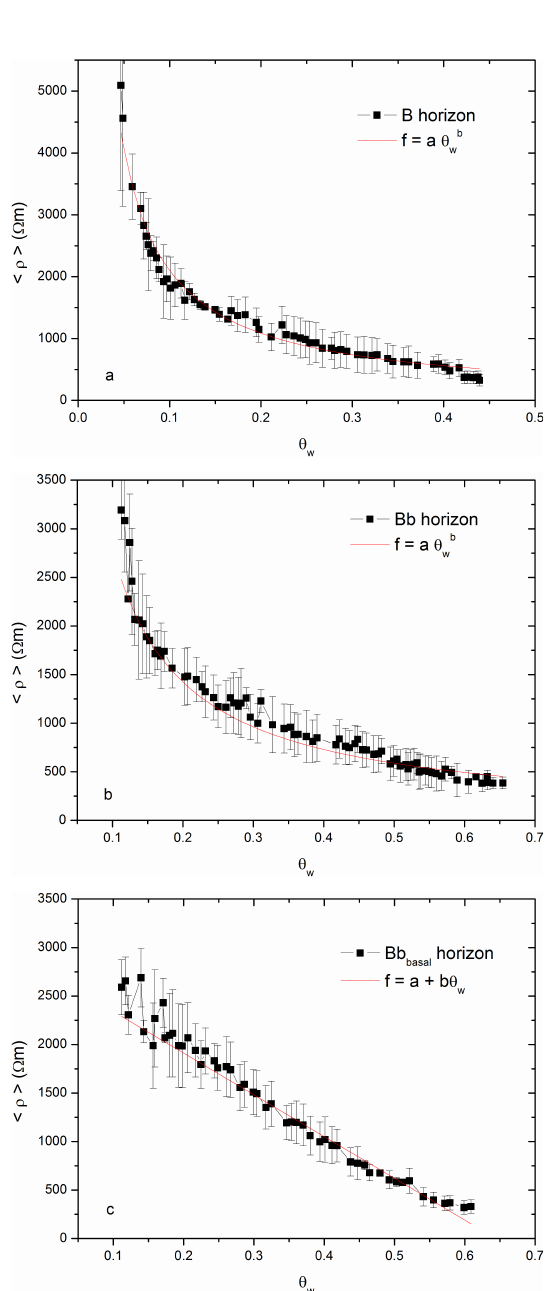
Fig. 6. Characteristic curves of resistivity vs. volumetric water con- tent for the investigated pyroclastic horizons: (a) B horizon, (b) Bb horizon, and (c) Bb basal